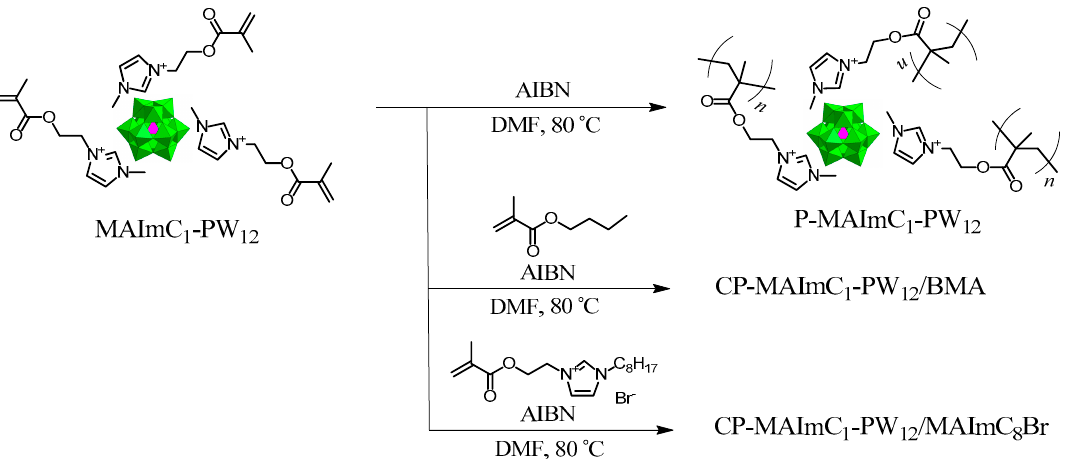
Table 2. Results of